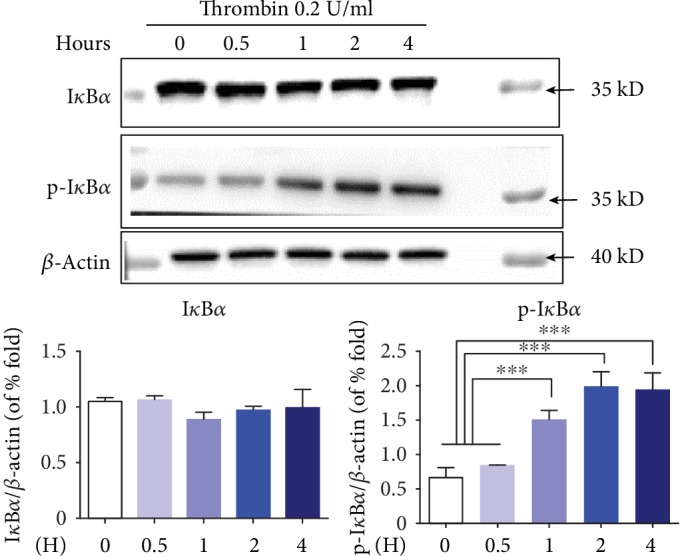
Expression of IκBα and phospho-IκBα in P815 cells at 0.5, 1, 2, and 4 h after treatment with 0.2 U/ml thrombin. The expression of phospho-IκBα in P815 cells increased obviously at 1, 2, and 4 h after incubation with 0.2 U/ml thrombin but not at the level of total IκBα. ANOVA was performed. Multiple comparisons were applied to compare the difference between each time. ∗ indicates that the difference between the control group and the diverse concentration of thrombin was statistically significant (∗P < 0.05; ∗∗P < 0.01; ∗∗∗P < 0.001).